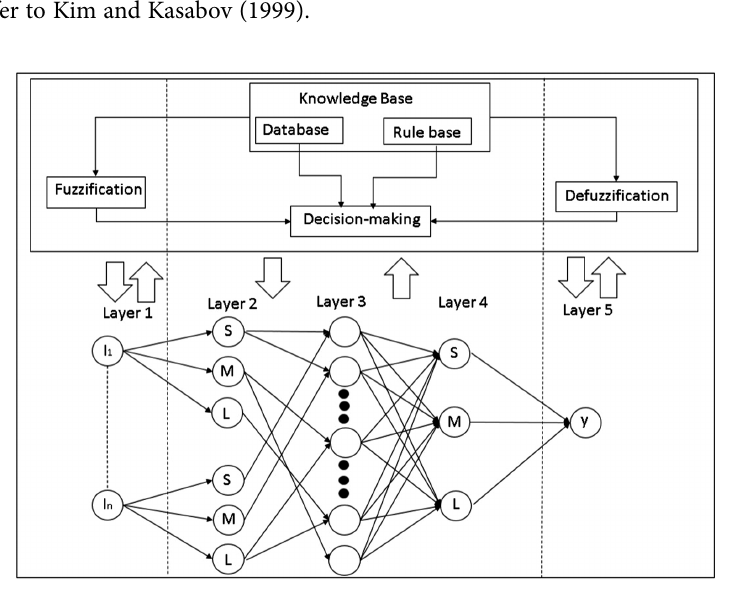
Figure 1. Architecture of the HyFIS, being S (small), M (medium) and L (large) linguistic